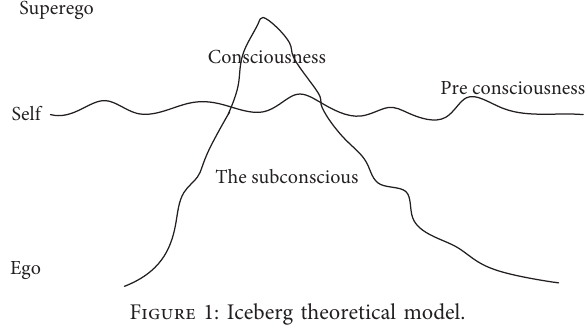
Figure 1: Iceberg theoretical